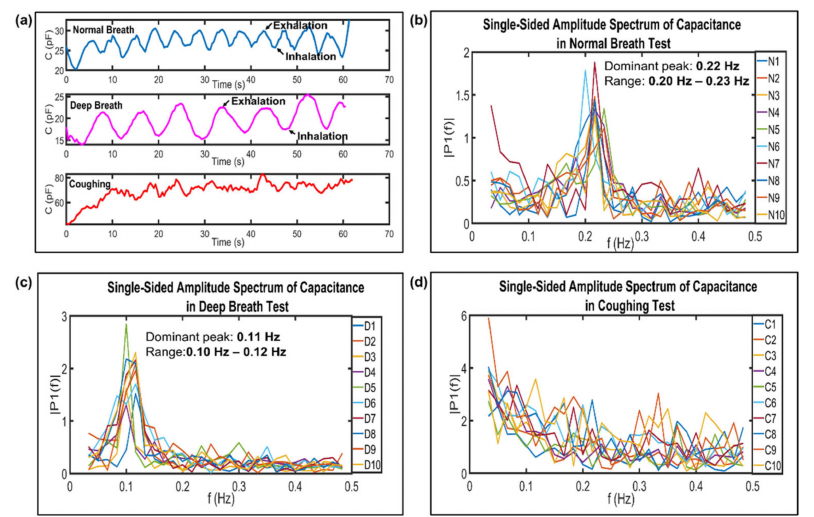
Figure 5. ( a ) The breath pattern of a subject under testing measured in terms of capacitance as a function of time during normal breathing (N), deep breathing (D), coughing (C), and the holding of breath (H). Single-sided amplitude spectrum of capacitance in ( b ) normal breath test, ( c ) deep breath test, and ( d ) coughing